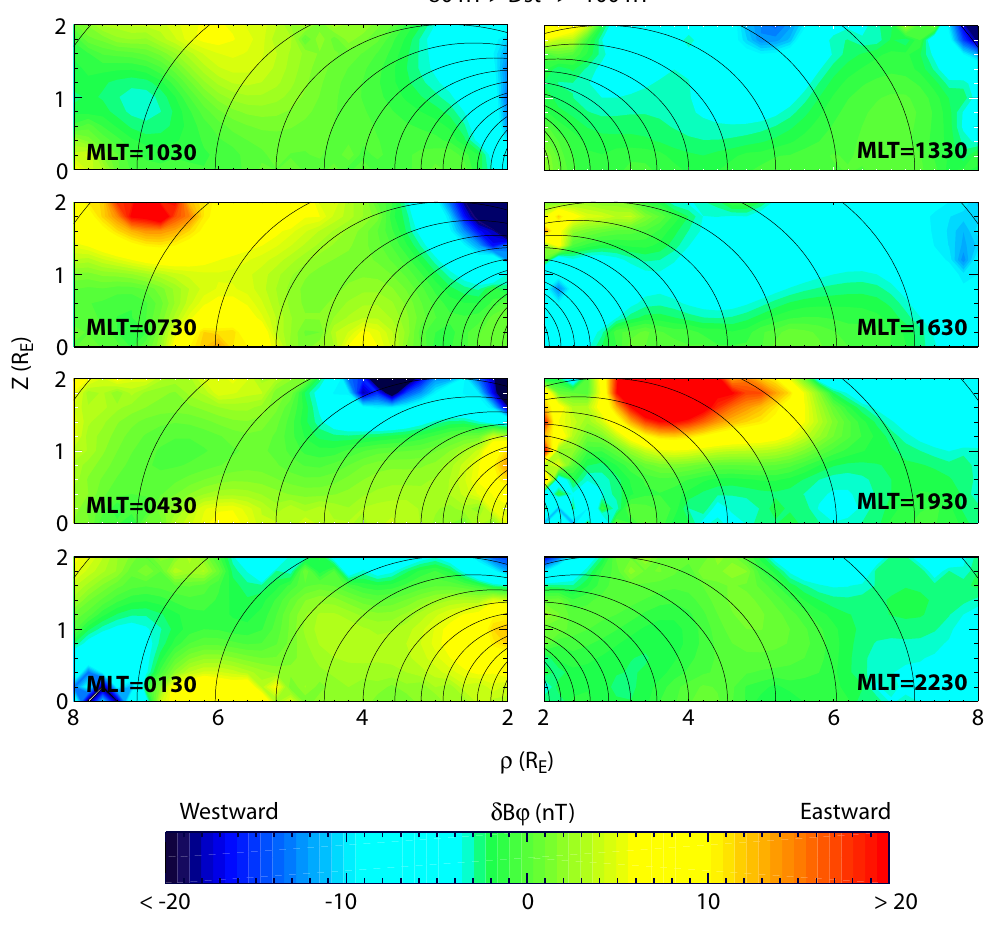
Fig. 5d. Azimuthal component of perturbation magnetic field with superimposed dipole field lines in each of the 8 magnetic local time bins and for each of the four D st * ranges. Only the northern meridian plane is shown. The southern part is anti-symmetric to the northern part: (d) − 80nT >D st * > −